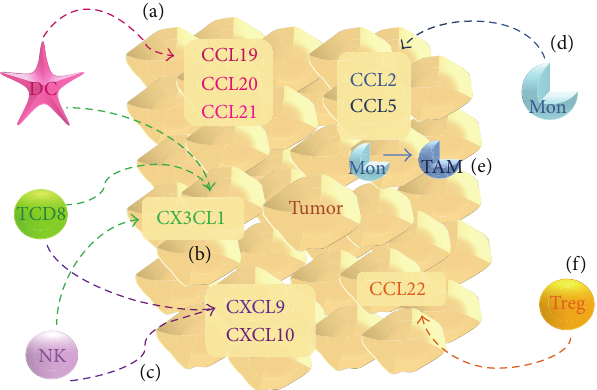
Figure 1: Chemokines influx the tumor microenvironment. (a) CCL19, CCL20, and CCL21 act as chemoattractants for dendritic cells (DC); (b) CX3CL1 has been related to infiltration of DCs as well as activated (cytotoxic) CD8+ T lymphocytes and NK cells. These last two populations are also chemoattracted by (c) CXCL9 and CXCL10. DCs, T CD8+ lymphocytes, and NK cells are thought to contribute to antitumoral immune response. (d) CCL2 and CCL5 are both chemoattractants for monocytes (Mon), which (e) within tumor microenvironment acquire a TAM phenotype. (f) CCL22 infiltration, which together with expression correlates with T reg TAMs promotes tumor survival and